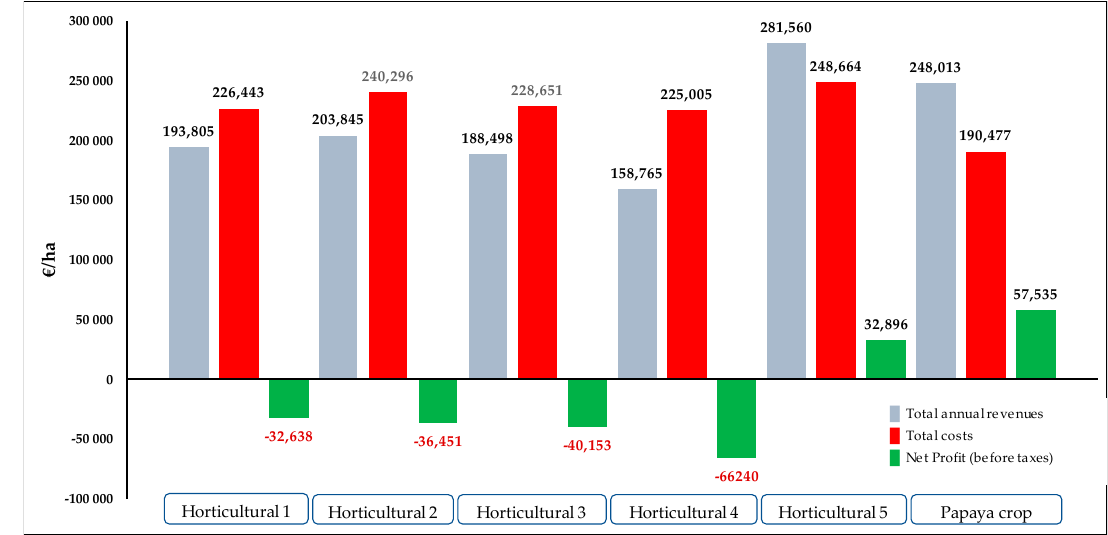
Figure 4. Comparison between the economic results (€/ha) of the proposed horticultural alternatives and the cultivation of the papaya in a 30-month cycle (2016–2018). Total annual revenues ( █ ); Total costs ( █ ); Net Profit (before taxes) ( █ ). Own elaboration.